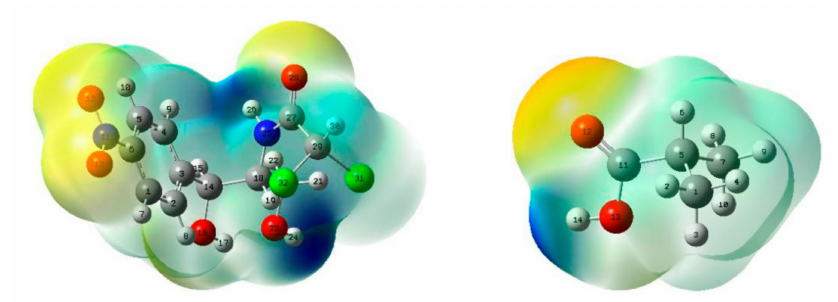
Figure 4. Molecular electrostatic potential (MEP) maps of CAP and